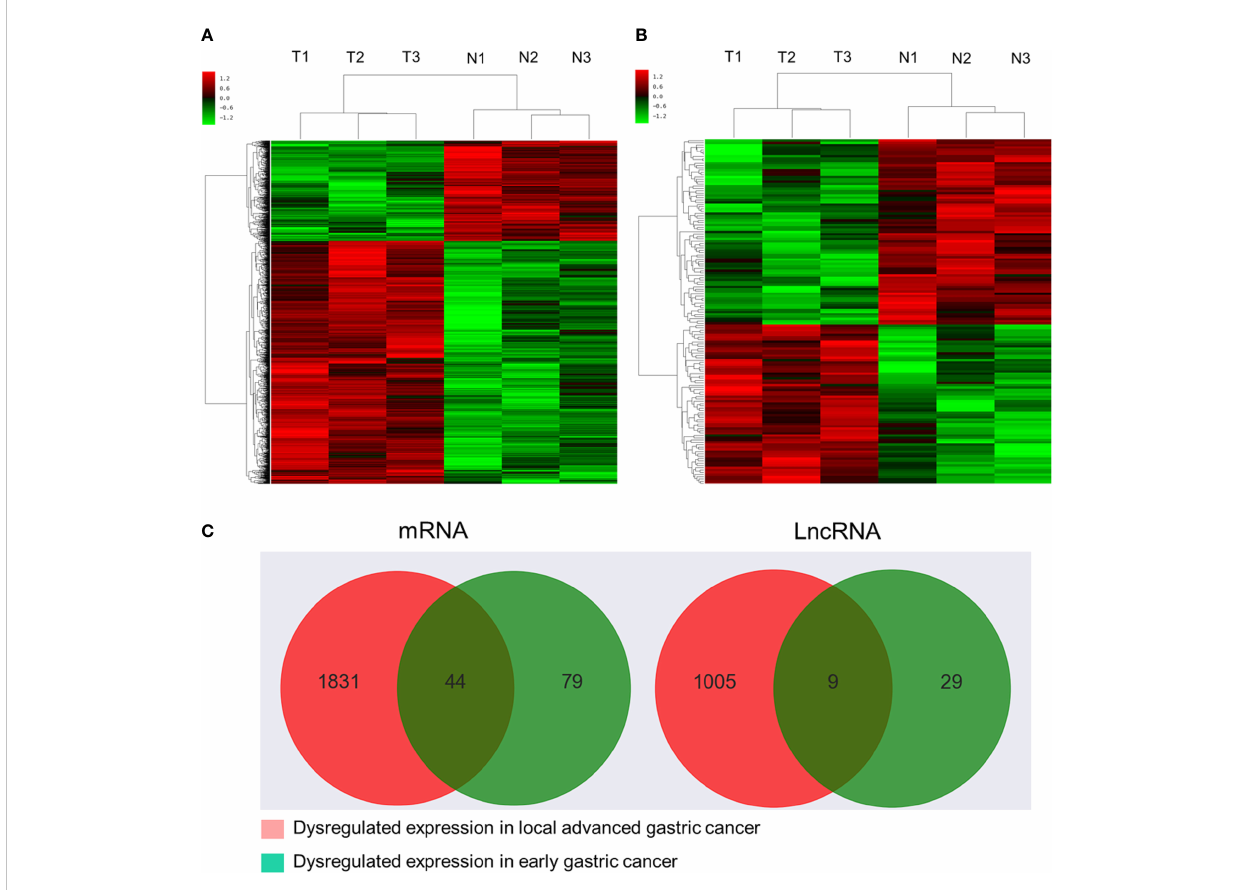
FIGURE 1 Microarray-based pro fi ling of mRNAs and lncRNAs differentially expressed between GC tumors and paracancerous tissues. (A) Hierarchical clustering heatmap of transcripts differentially expressed between local advanced GC and paracancerous tissues. (B) Hierarchical clustering heatmap of transcripts differentially expressed between early GC and paracancerous tissues. (C) Venn diagram analysis of lncRNAs and mRNAs differentially expressed between locally advanced GC vs. paracancerous tissues and early GC vs. paracancerous